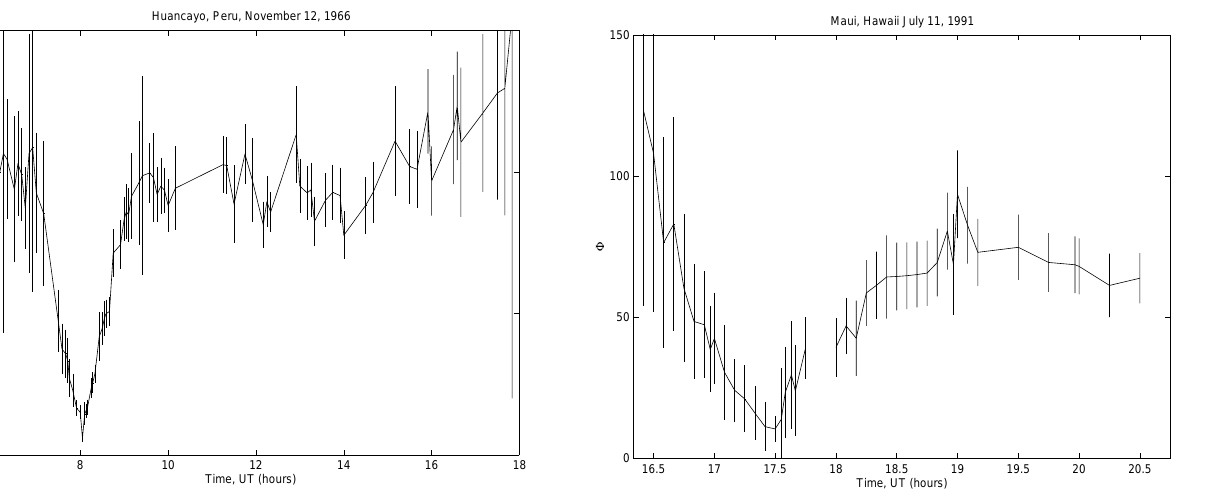
Fig. A6. The variation of 8 during the eclipse of 12 November 1966 at Huancayo, Peru as calculated using Eq. (2) and the data shown in Fig. A5.